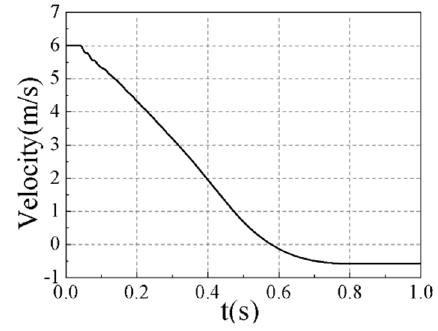
Figure 7. The time-history speed of the ship.